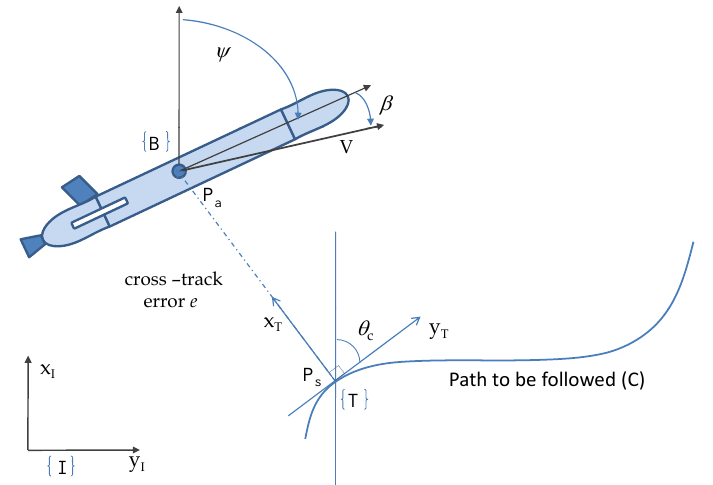
Figure 12. Cross-track error for straight-line